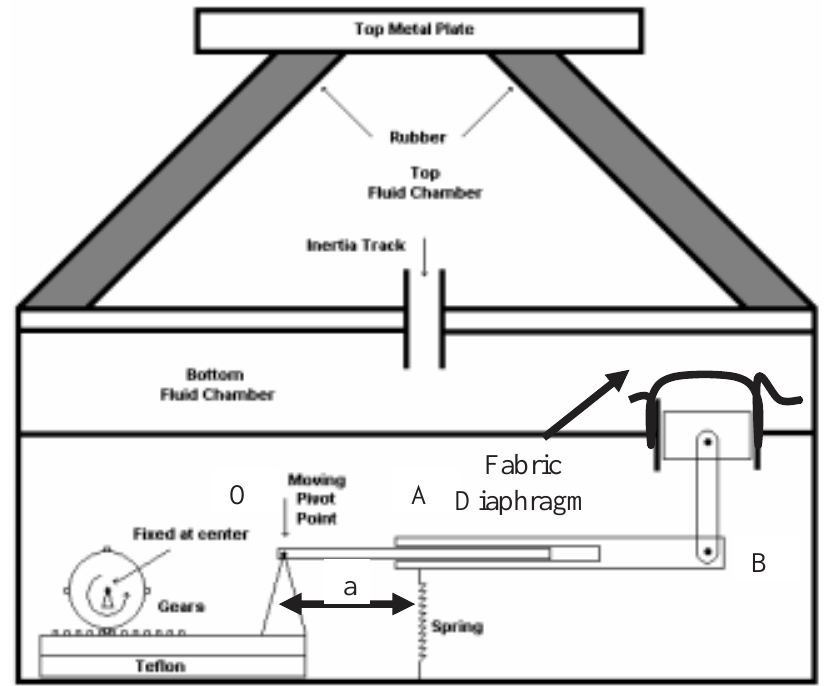
Fig. 8. Variable Bottom Chamber Volume Stiffness Fluid Mount Design.